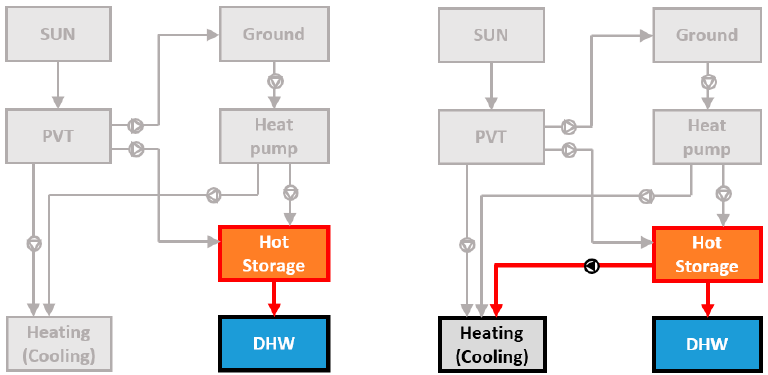
Figure 27. System diagram of comparison considering storage tank heating.